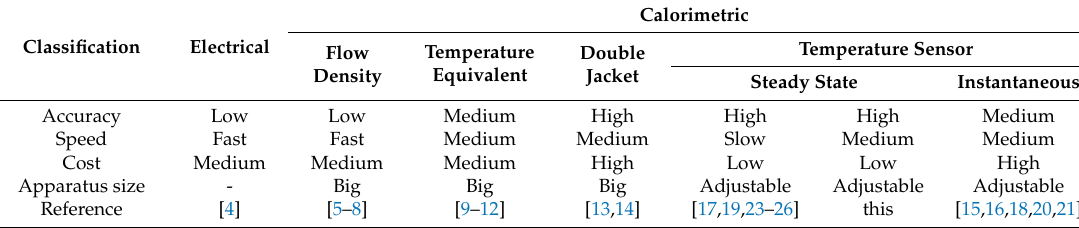
Table 1. Comparison of loss measurement methods.